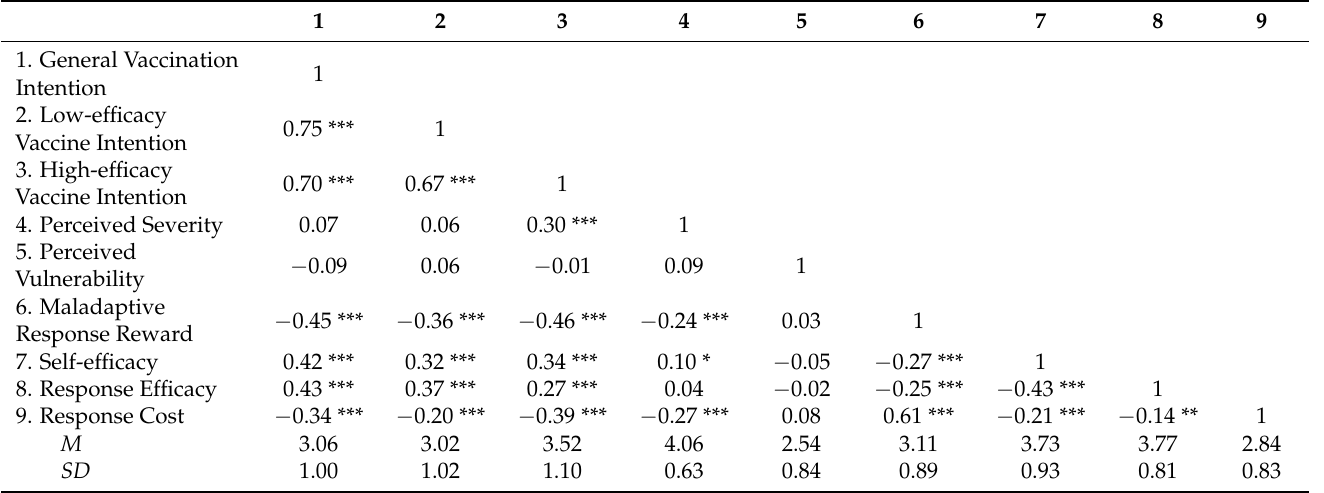
Table 2. Descriptive statistics and bivariate